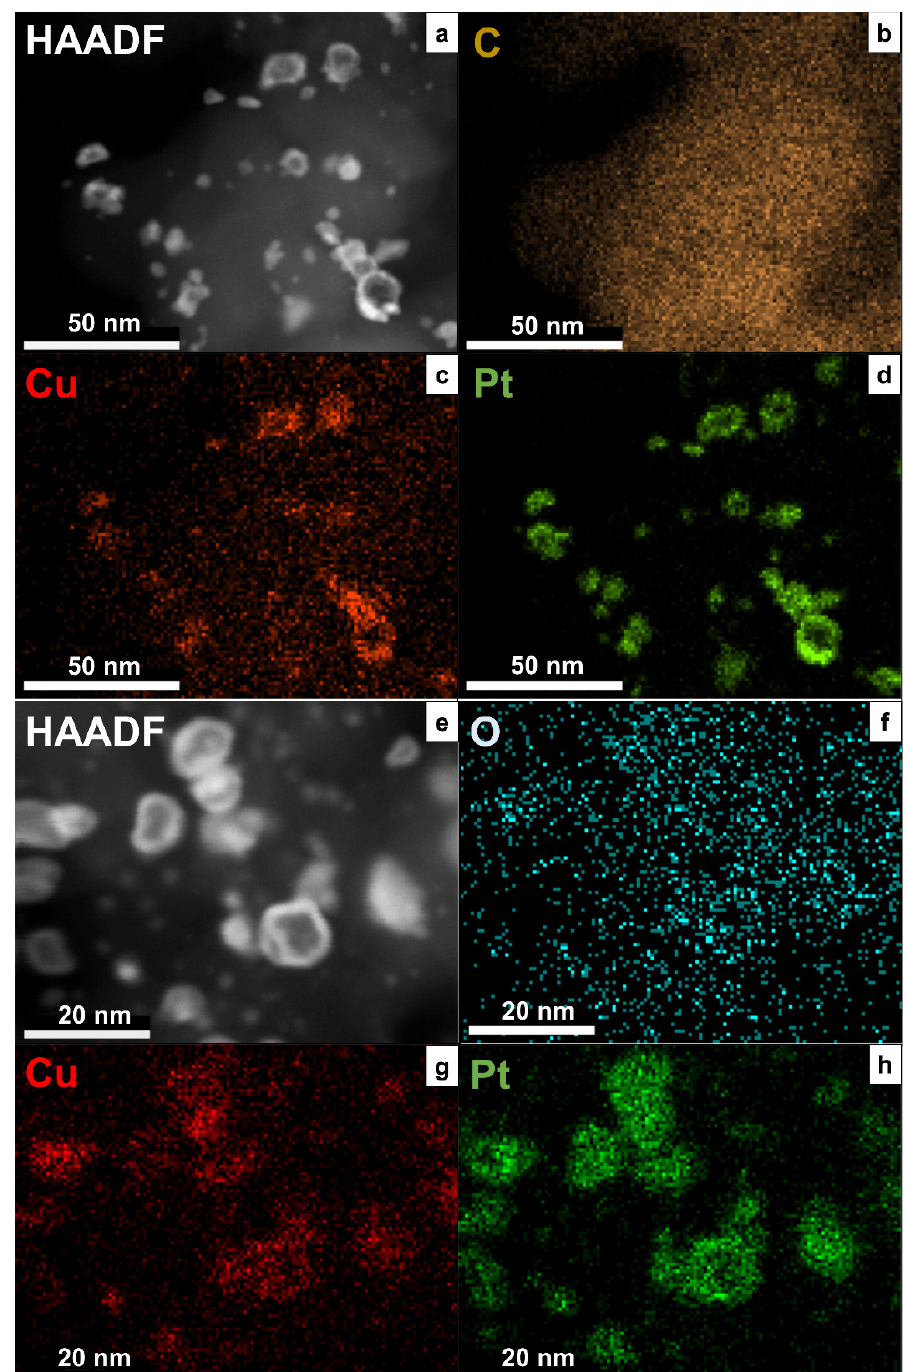
Figure 4. HAADF STEM for PtCu nanoparticles with core–shell structure ( a ) and with “gradient” structure ( e ) and EDX mapping of C ( b ), Cu ( c , g ), Pt ( d , h ), O ( f ) for these materials.